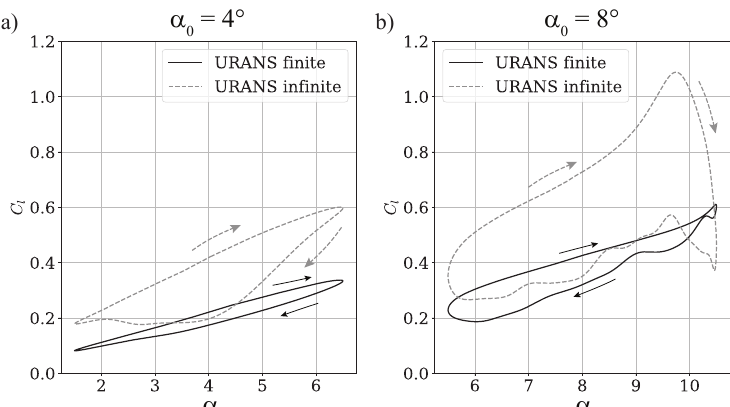
Figure 14. Comparison of unsteady lift coefficients for finite and infinite span configuration. ( a ) α 0 = 4 ◦ , ( b ) α 0 = 8